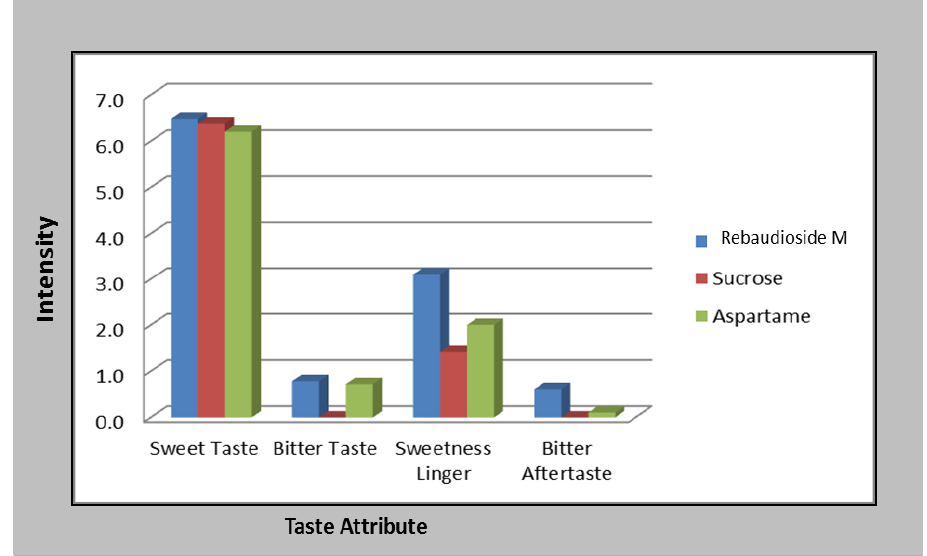
Figure 6. Descriptive taste profile of rebaudioside M ( 7 ) at 563 mg/L, aspartame at 531 mg/L and sucrose at 10% in